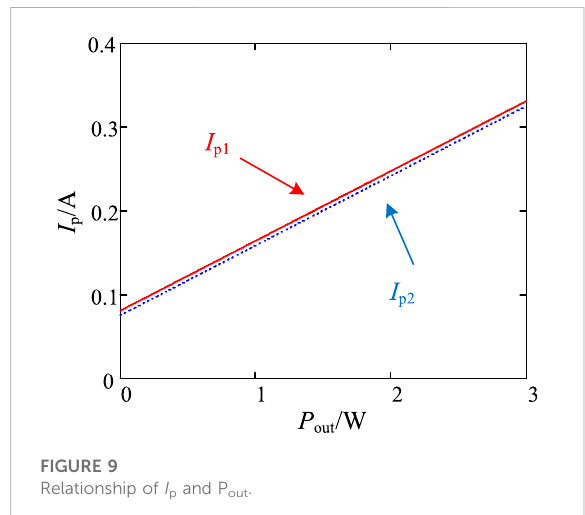
FIGURE 9 Relationship of I p and P out